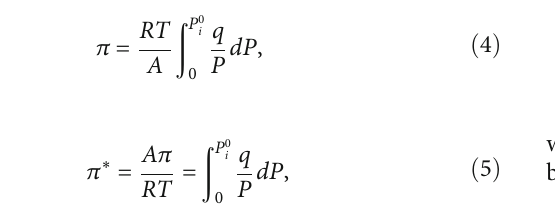
Figure 4: Ratios of adsorption amount of CO di ff erent temperatures.